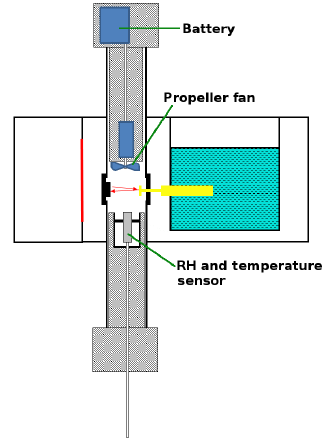
Figure 11. Schematic of the CFH ground check